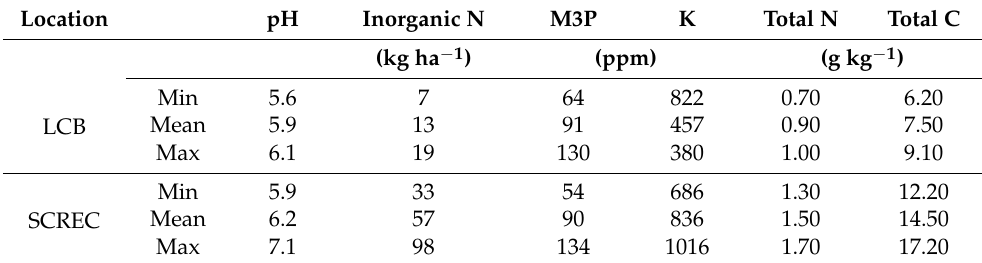
Table 2. Mean, minimum, and maximum soil chemical properties at trial initiation of each location of the study. Lake Carl Blackwell (LCB) and the South-Central Research and Extension Station (SCREC).